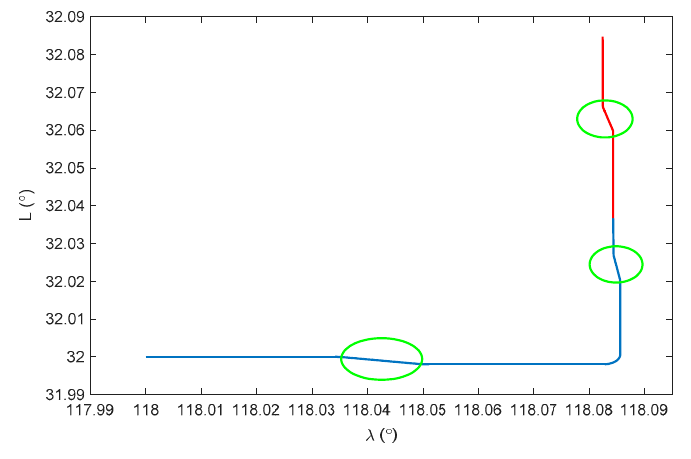
Figure 2. Navigation trajectory.